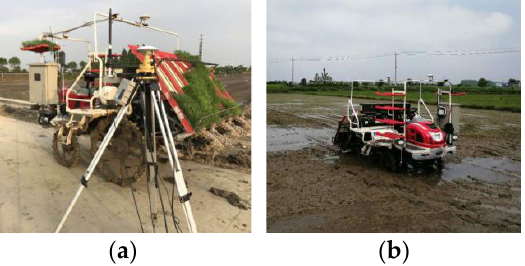
Figure 9. Experimental platform and Path tracking test. ( a ) Test platform; ( b ) field experiment.